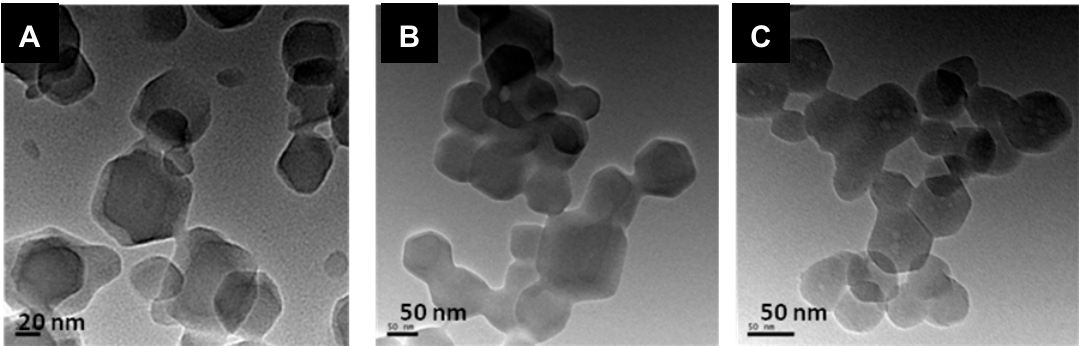
Figure 8. XRD patterns of fresh ZIF-8 (a), recovered ZIF-8 after three cycles (b) and after six cycles (c) from the reaction between 2-nitrobenzladehyde and malononitrile in water at 40 °C.